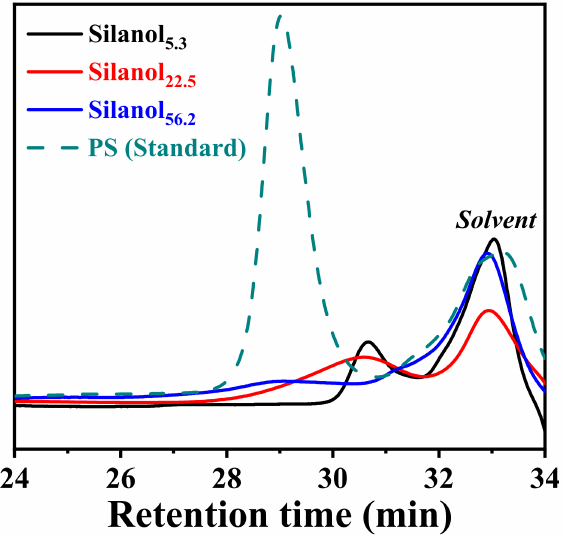
Figure 3. GPC curves of silanol-terminated PDMS with different chain lengths.